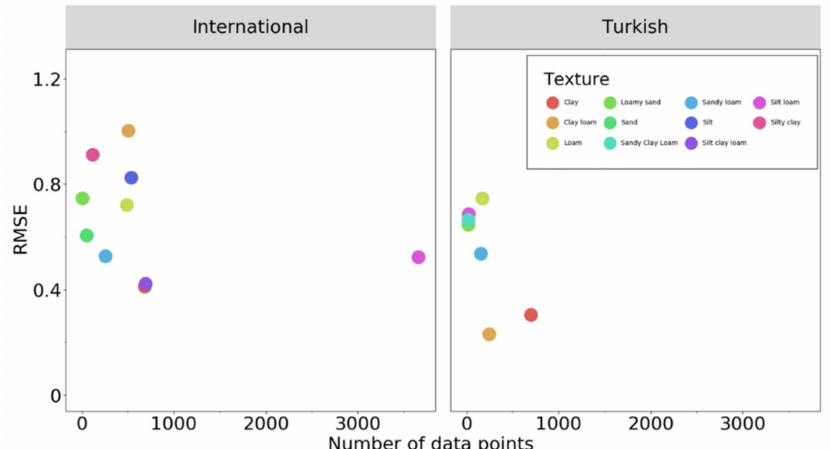
Figure 5. The root of mean squared error (RMSE) as a function of the number of measured hydraulic conductivity data pairs for each textural class for the PC NN -PTF Model 1 with SSC, BD, SOM as inputs. The model was developed using combined international and Turkish data